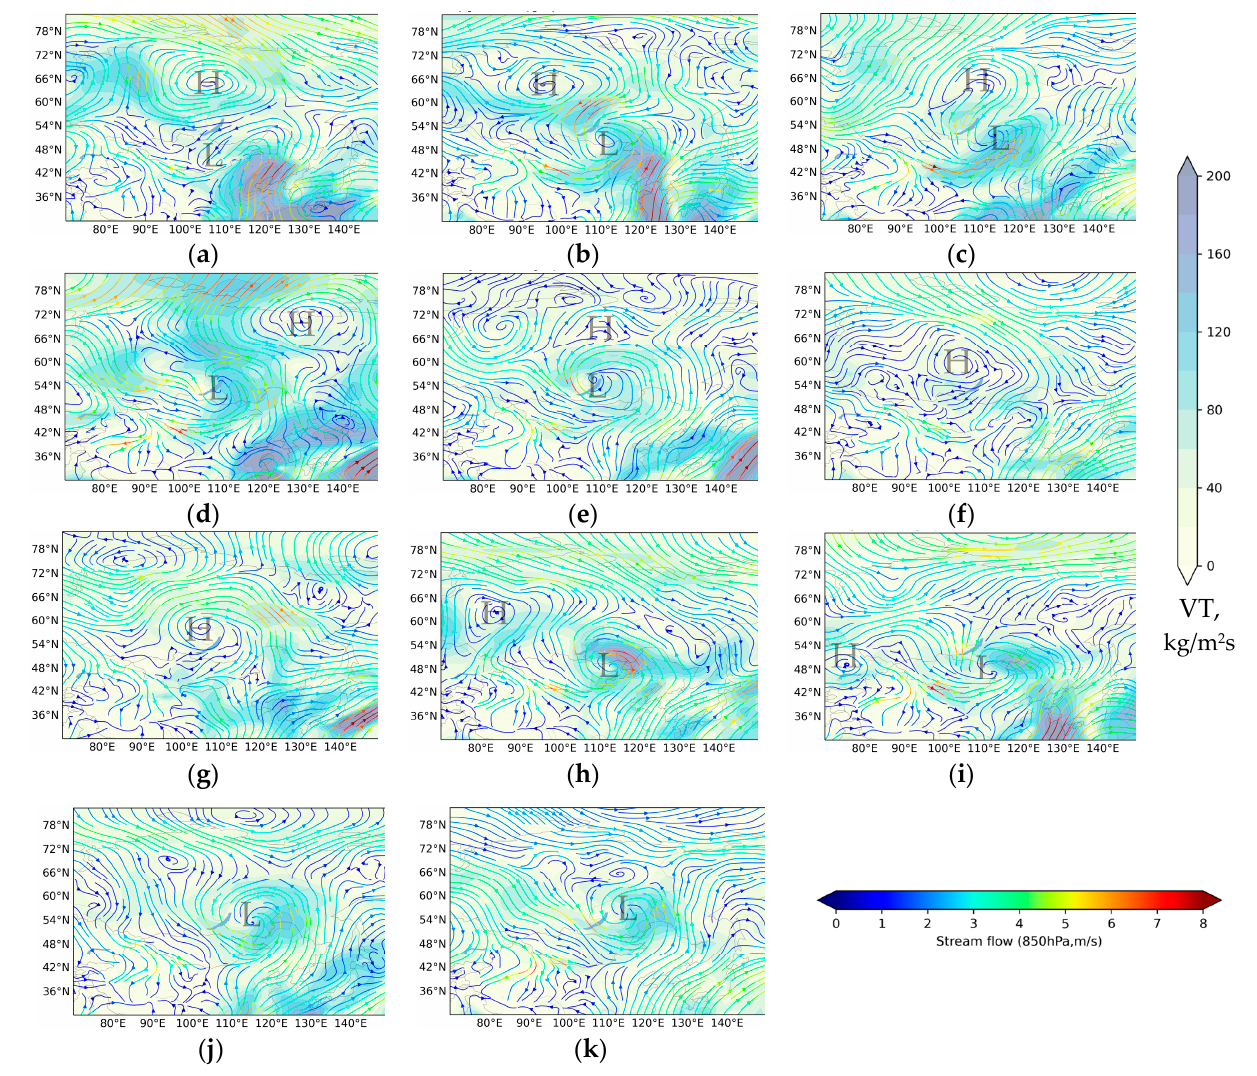
Figure 4. The average streamlines at 850 hPa and water vapor transport. ( a ) М 2 (1982-1998), ( b ) SES-